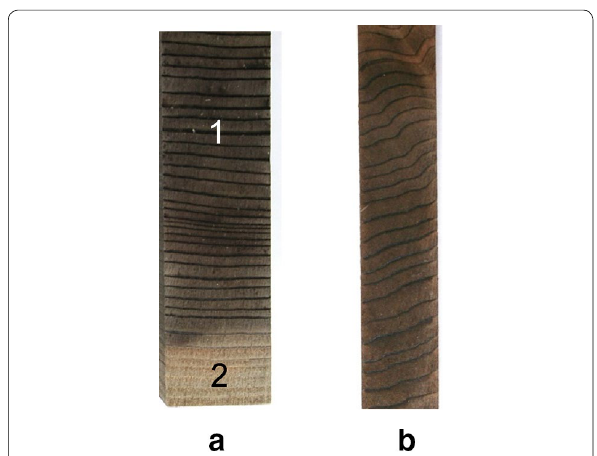
Fig. 1 Photographs of the cross-section of three parts in two Japanese cedar umoregi wood samples for (a-1) UW1-1, (a-2) UW1-2, and (b) UW2. UW1-1: heartwood, UW1-2: sapwood, UW2: heartwood